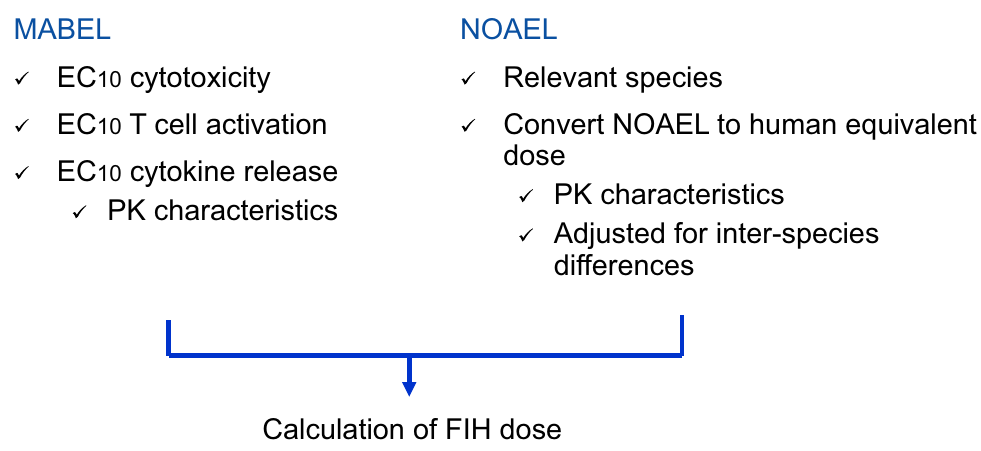
Figure 1. Strategy to determine the FIH dose of ERY974. Pharmacology data exploiting the MABEL approach and toxicology data in cynomolgus monkeys to determine the NOAEL were combined to determine FIH dose of ERY974. FIH, first-in-human; MABEL, minimal anticipated biological effect level; NOAEL, observed adverse effect